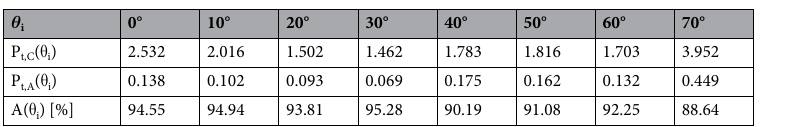
Table 1. Calculated absorptivity from the measured relative power reflected from the copper and proposed